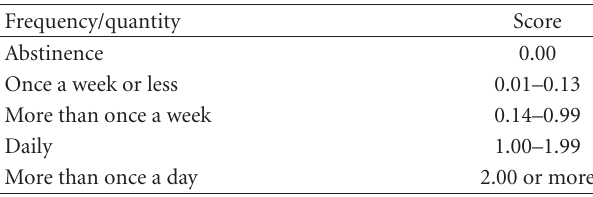
Table 5: Opiate treatment index scores interpretation